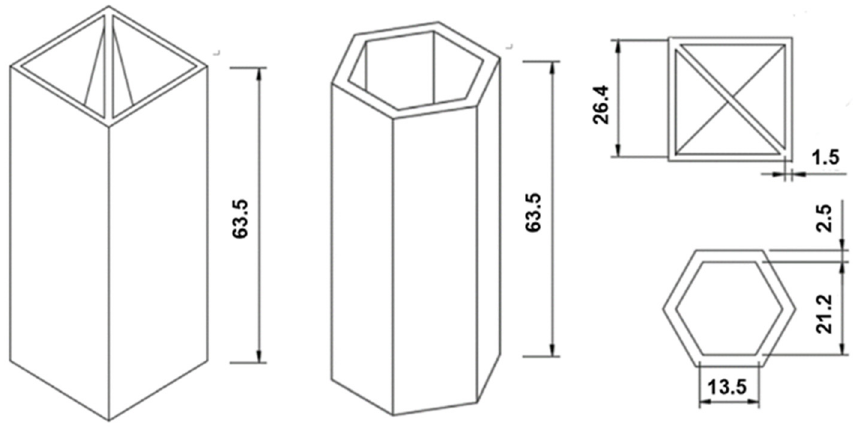
Figure 3. Dimensions (in mm) of innovative and standard hexagonal cells specimens for testing.